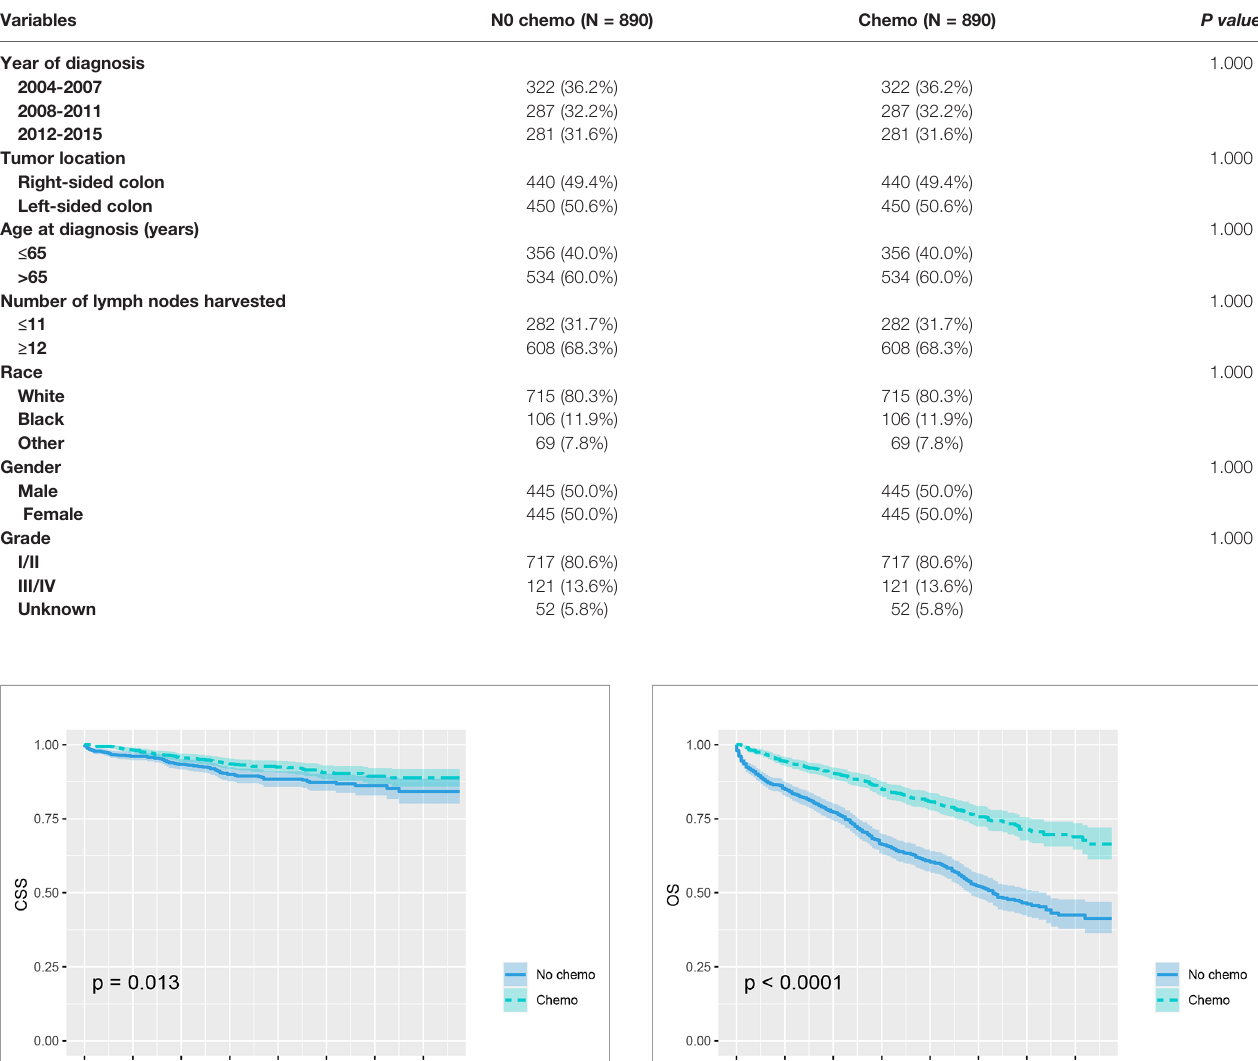
TABLE 4 | Clinicopathologic characteristics of T1N+ colon cancer patients according to the receipt of chemotherapy after propensity score matching. Variables